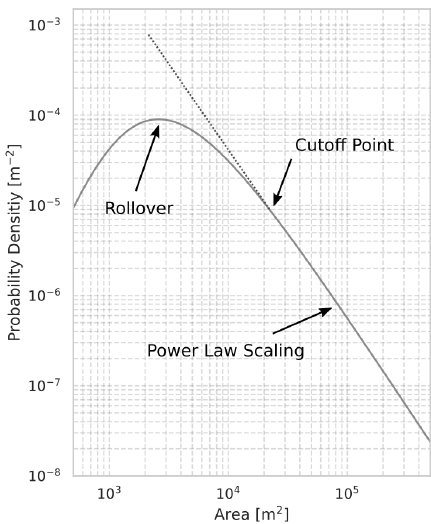
Figure 2. Schematic representation of RTS area probability density function. Two parts can be distinguished: an exponential-decay part above the cutoff value and a deviation from the power law scaling below the cutoff